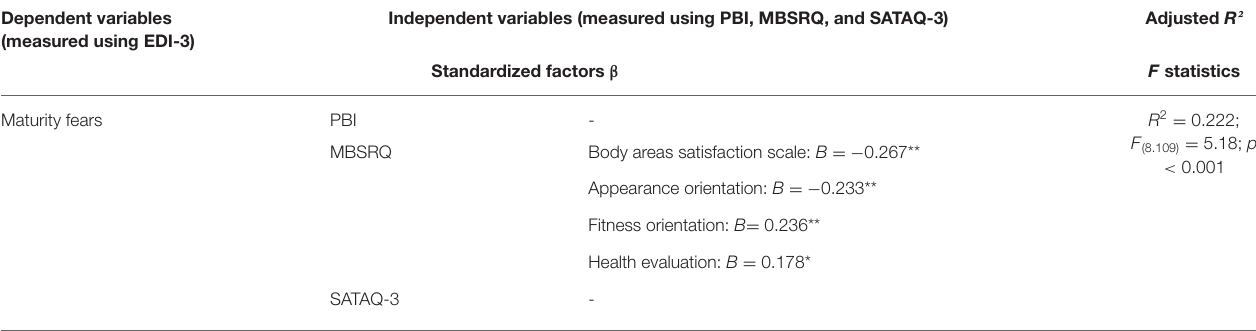
Independent variables (measured using PBI, MBSRQ, and